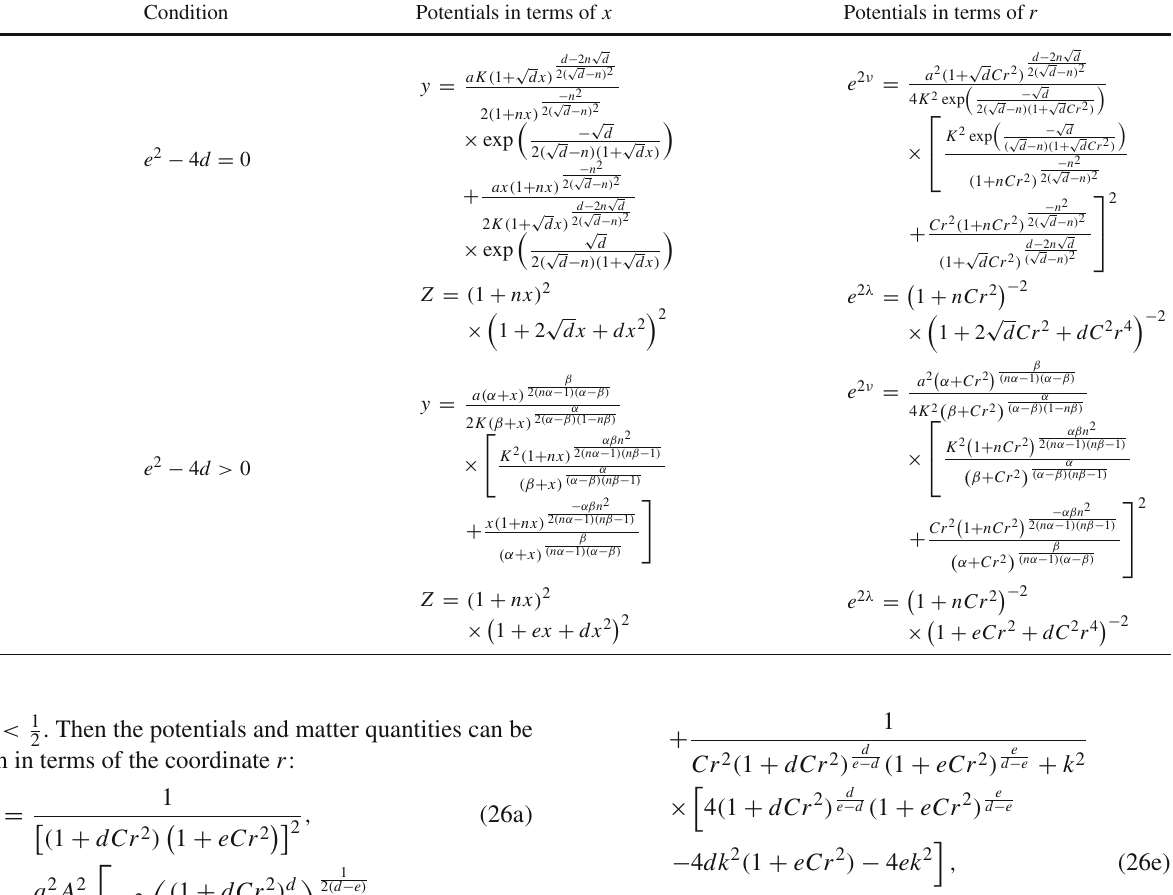
Table 3 Potentials for Class III models Case Condition Potentials in terms of x Potentials in terms of